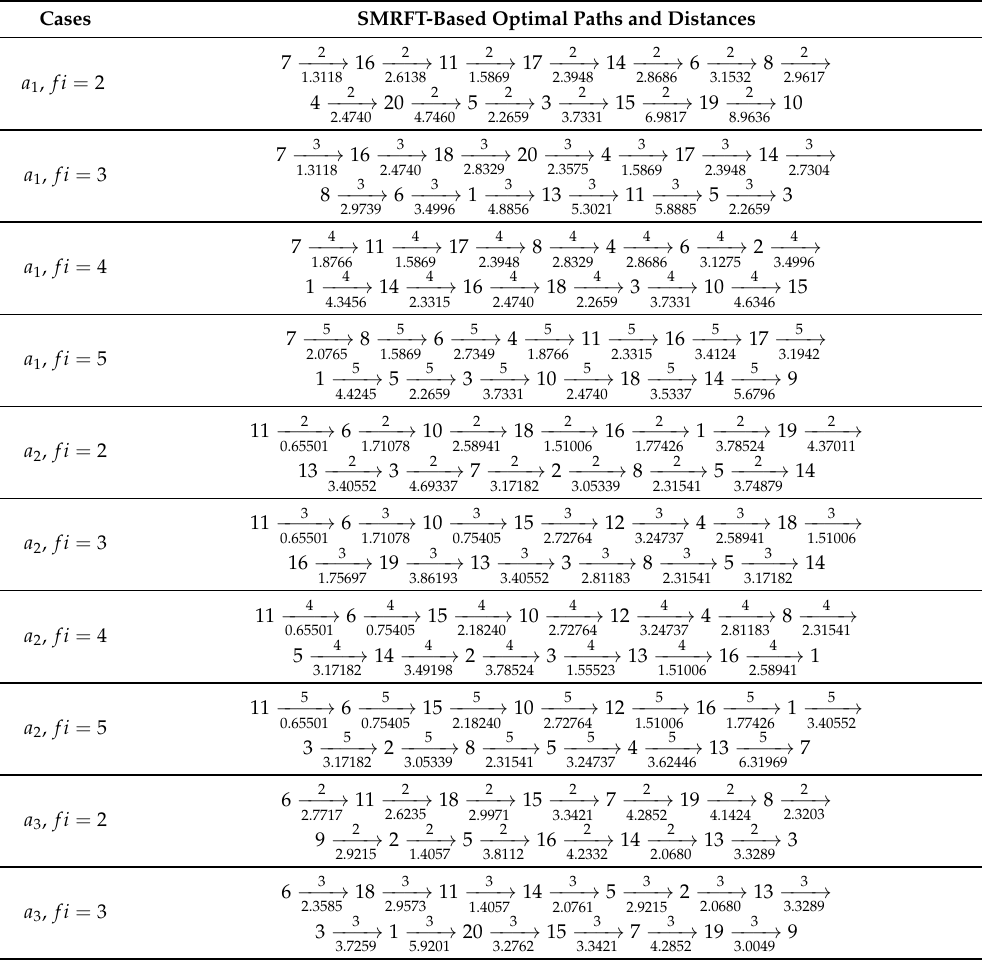
Table 5. SMRFT-based optimal paths and distances for animal 1, 2 and 3 under foraging radial levels 2, 3, 4 and